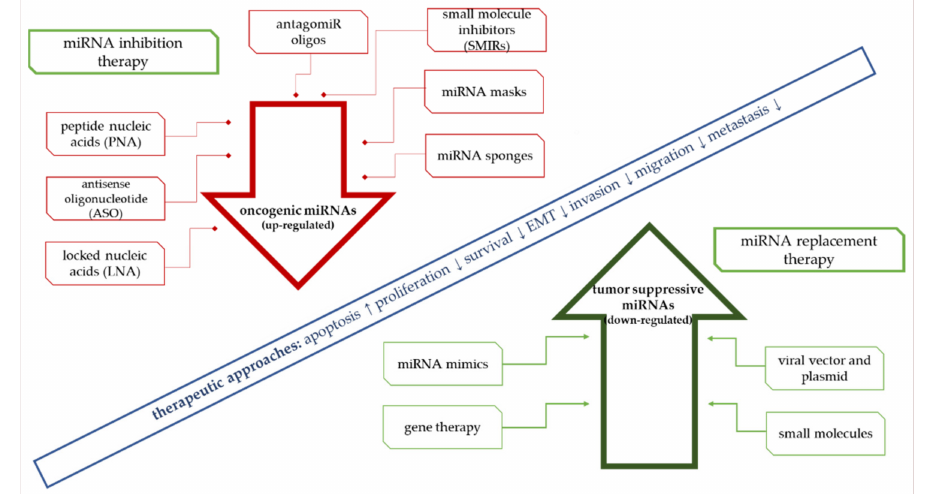
Figure 1. Approaches for miRNA-based